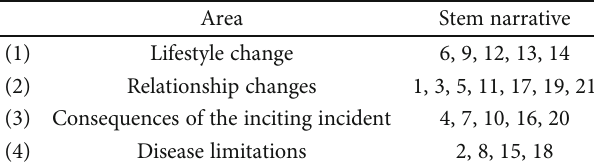
Table 1: Stem narratives according to area ∗